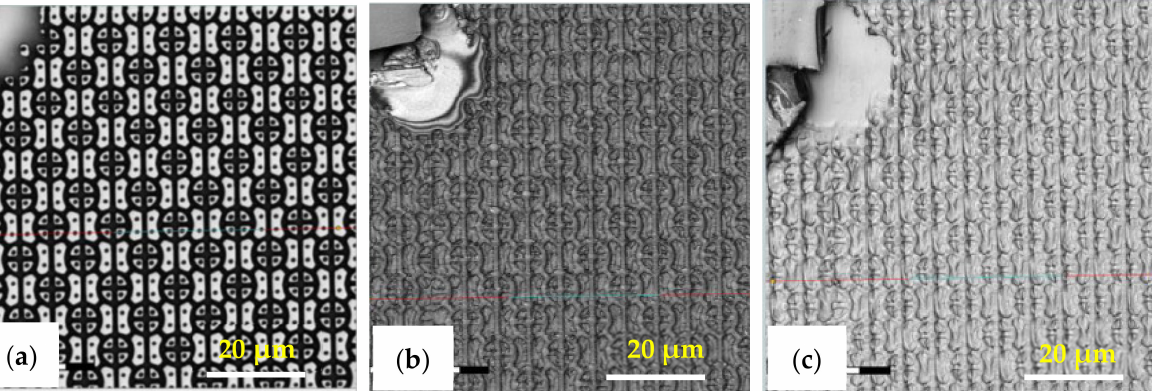
Figure 13. Top-view laser confocal microscopy images of the C-RESS micro-structure (pattern design: size: 1.5 µ m, space: 0.5 µ m, height: 2.5 µ m) on the ( a ) Si master mold before in-house releasing agent treatment (i.e., with HMDS vapor priming), ( b ) imprint on PET foil with resin A (C-RESS-A), and ( c ) imprint on PET foil with resin B (C-RESS-B). Note that the artefact seen in the top left corner is part of the design on the Si master mold and is therefore copied onto the samples.